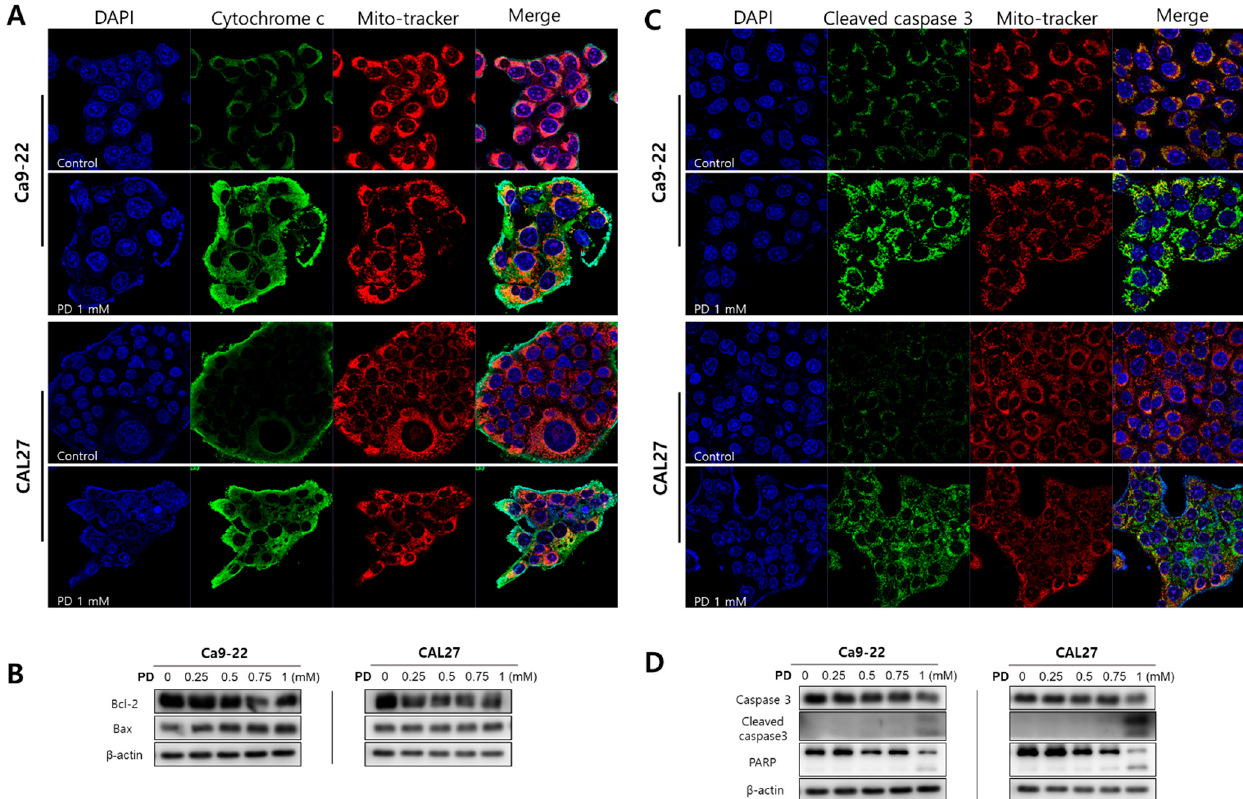
Figure 3. Expression of apoptosis-related proteins by polydatin in OSCC cells. After a 24-h treatment with 1 mM polydatin, the expression of ( A ) cytochrome c and ( C ) cleaved caspase-3 in Ca9-22 and CAL27 cells were confirmed through immunofluorescence staining as observed under a confocal microscope. After a 24-h treatment with 0–1 mM polydatin, the protein expression of ( B ) bcl-2, bax ( D ) caspase-3, cleaved caspase-3, and PARP was confirmed through Western blot analysis. β -actin was used as loading control.